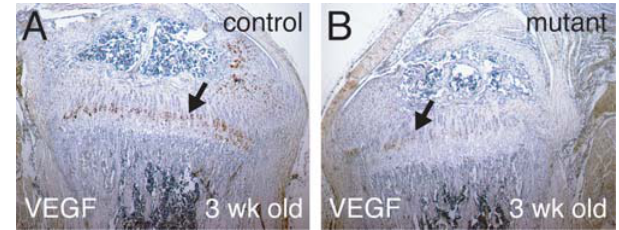
Figure 8. VEGF immunohistochemistry of 3-week-old tibiae. A, B, VEGF immunostaining (brown) in growth plates of 3-week-old tibiae. A, The control stained strongly for VEGF in prehypertrophic and hypertrophic chondrocytes (arrow). B, VEGF immunostaining in the R26 floxneoWnt4 ; Col2a1-Cre mutant tibia was weaker and restricted to prehypertrophic chondrocytes